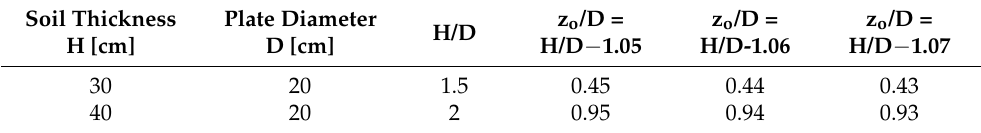
Table 2. Values of critical relative sinkage (breaking points), according to Equation (2).